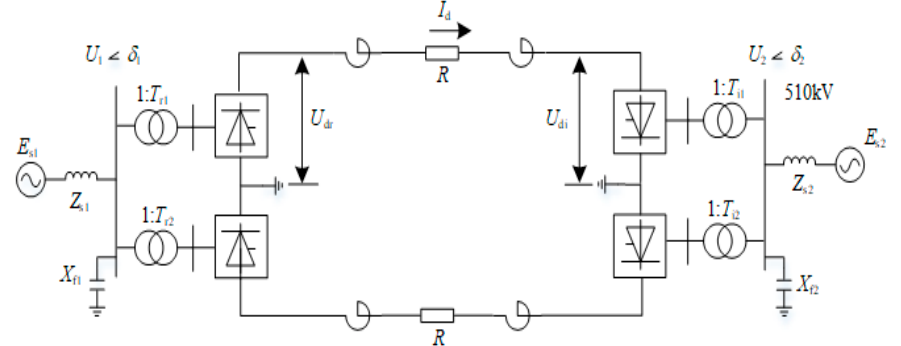
Figure 1. Circuit of LCC-HVDC